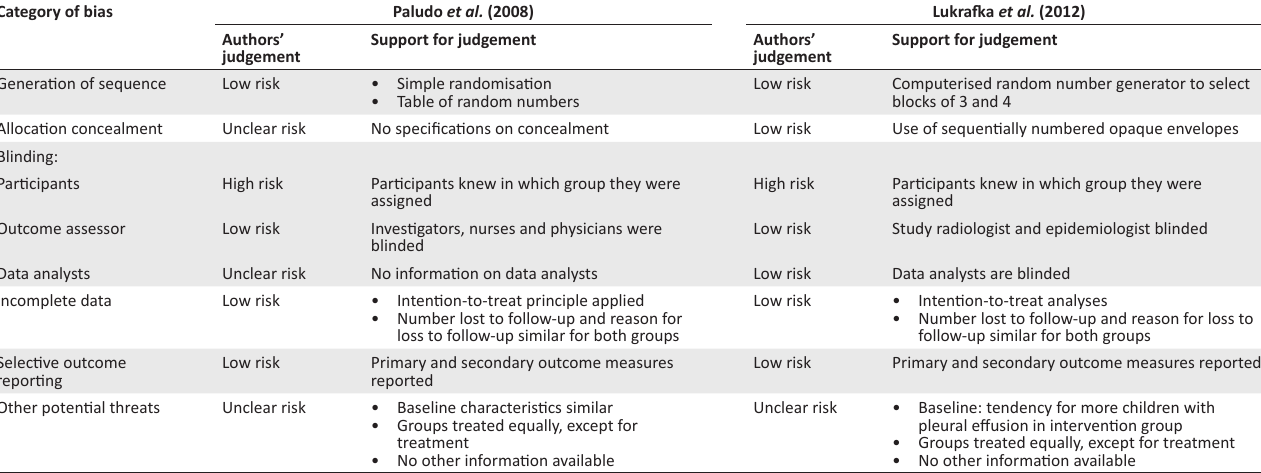
TABLE 3: Risk of bias. Category of